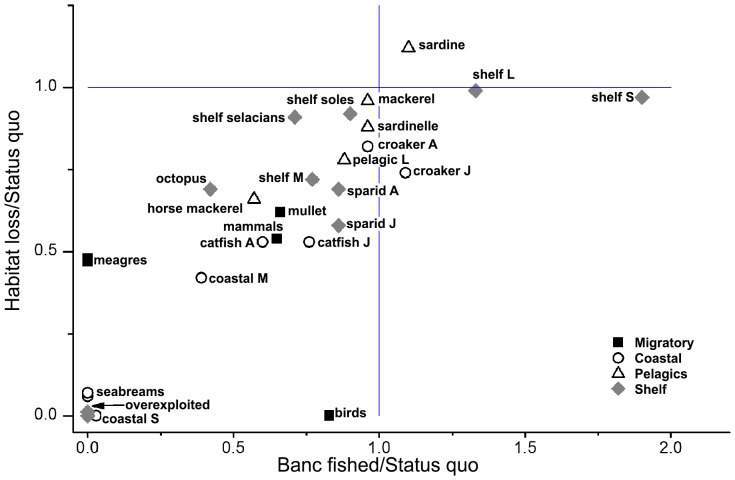
Relative biomass compared to the status quo under two scenarios: adding the fictive fleet in the Banc (Bfict/BSq in x-axis) and the habitat loss in the Banc (BLoss/BSq in y-axis).A = adult, J =  juvenile.